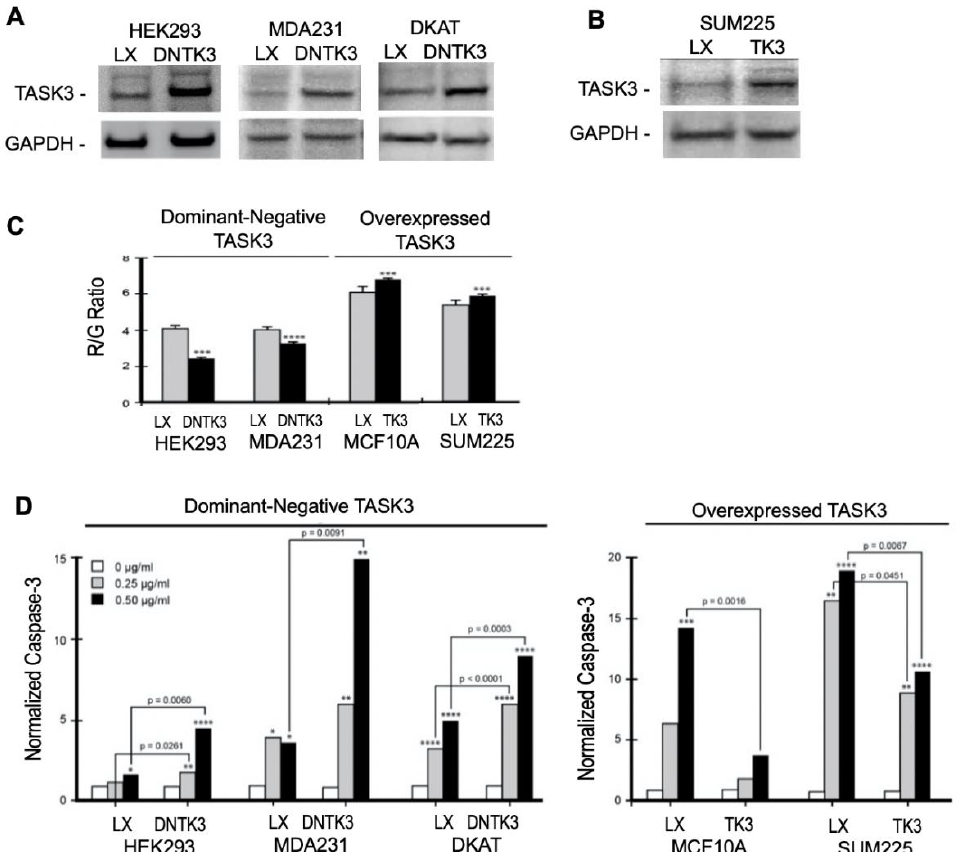
Figure 6. TASK3 expression regulates mitochondrial membrane potential and sensitivity to staurosporine-induced apoptosis.